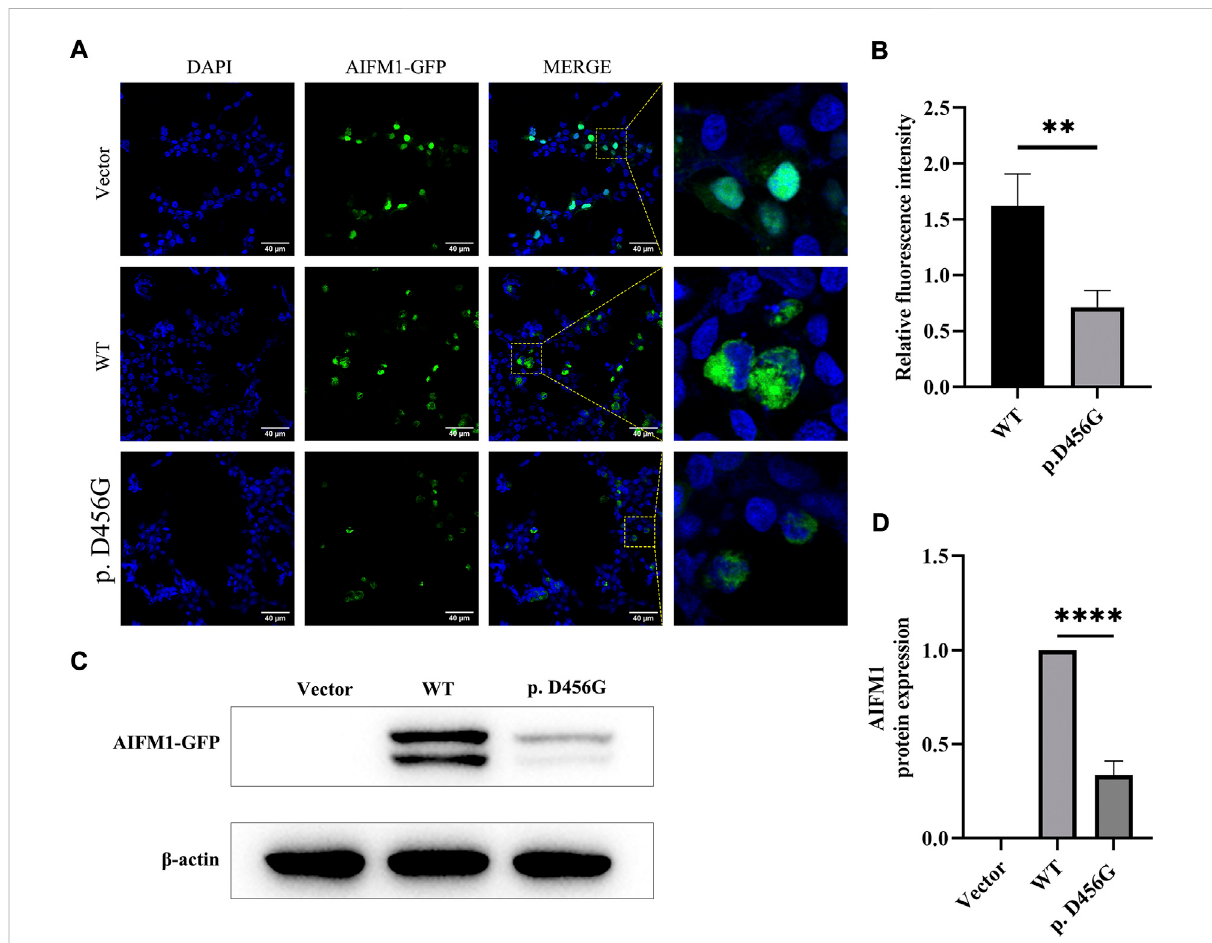
FIGURE 4 Subcellularlocalizationandproteinexpressionofwildtype(WT)andp.D456G AIFM1 proteinsinHEK293cells. (A) SubcellularlocalizationofWT and p. D456G AIFM1 proteins in HEK293 cells shown in DAPI, GFP-tagged, and merged images. GFP fl uorescence is detected after the transient transfection in HEK293 cells. Scale bar = 40 μ m. (B) Quantitative analysis of fl uorescence intensity based on images shown in (A) . The data are presented as mean ± standard deviation (SD) of three biological replicates. The signi fi cant difference is set at p < 0.01 (**) based on the two- tailed unpaired t-test. (C) ExpressionsofWT and p. D456G AIFM1 intransfected HEK293 cells based on Western blotusinganti-GFPand anti- β -actin (i.e.,internalcontrol)antibodies. (D) Quantitativeanalysisofproteins shownin (C). Thedataarepresented asmean±standarddeviation(SD)ofthree biological replicates. The signi fi cant difference is set at p < 0.0001 (****) based on the one-way ANOVA with Dunnett ’ s multiple comparison